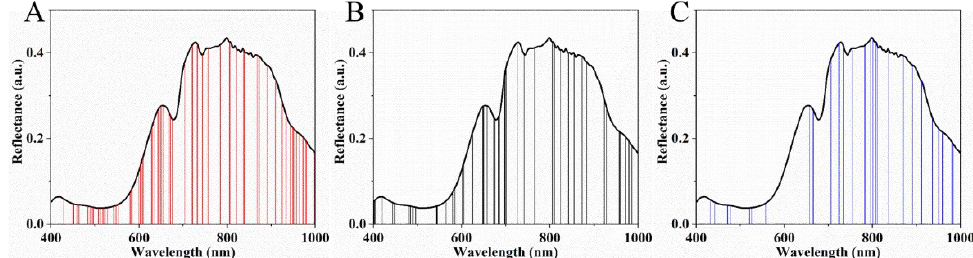
Figure 5. Important wavelengths selected by CARS for ( A ) SSC, ( B ) pH, and ( C ) VC. ForVC,thelowestpredictionerrorsare R c 2 = 0.9228, RMSEC = 0.0185, R p 2 = 0.9109, RMSEP = 0.0237, and the results are got from PLSR model developed by the spectra of 27 wavelengths selected by CARS (Figure 5C) and 23 textural features. The 23 features include 18 textural features from the image of 837 nm and low grads dominance, grads asymmetry, gray variance, correlation, and grads entropy from the image of 891